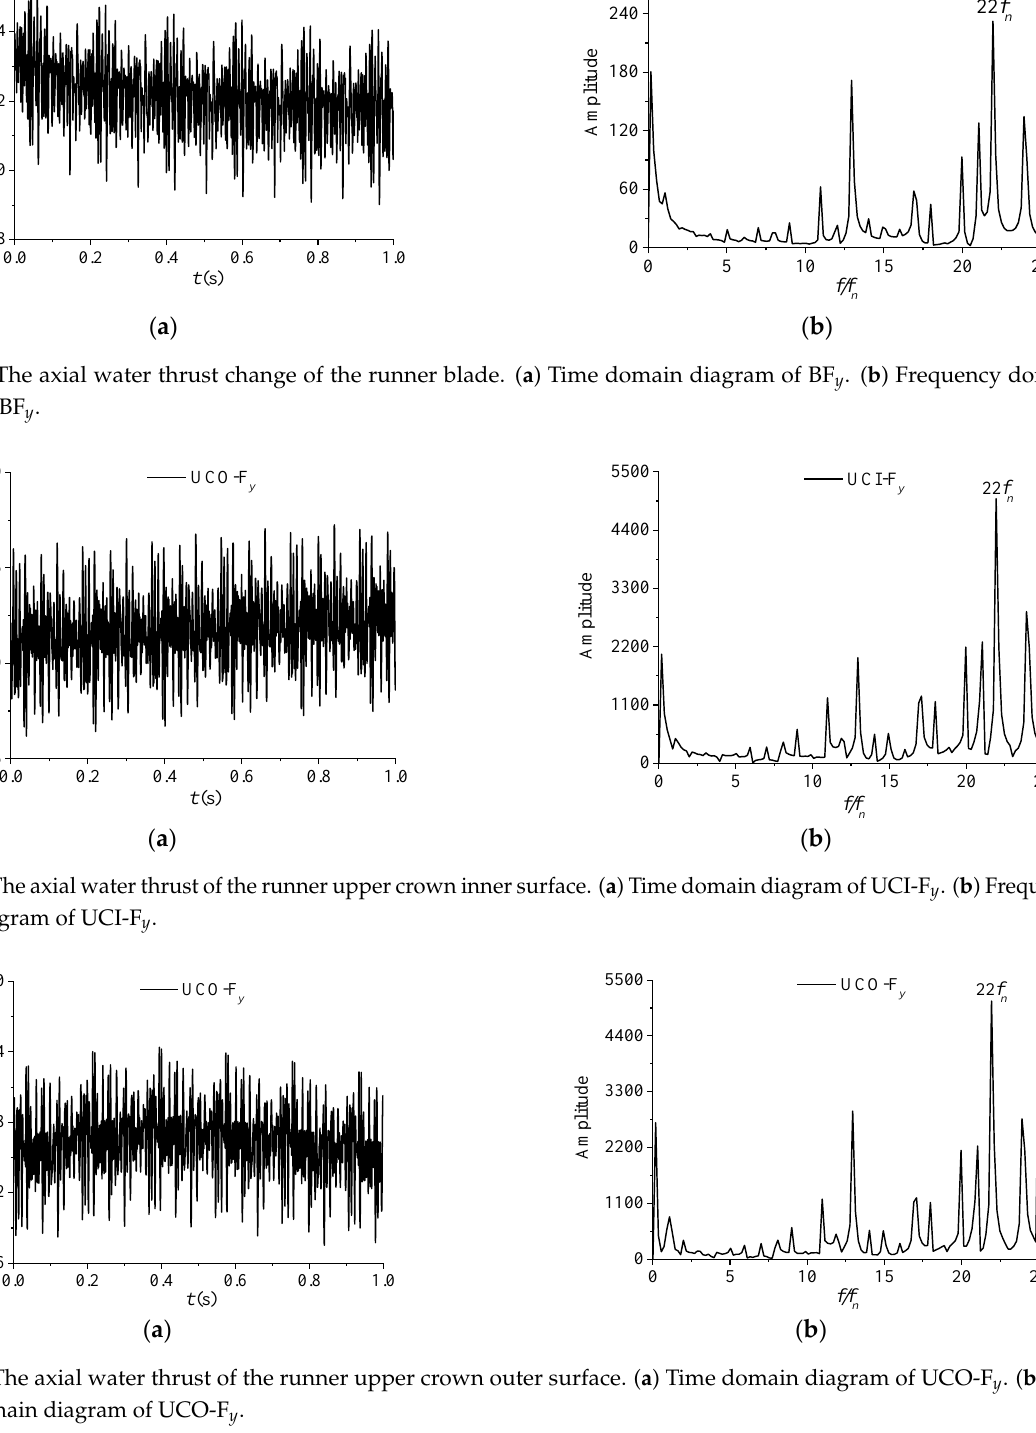
( f ) 1.0 T Figure 10. The internal flow characteristics of guide vanes and runners in one period.